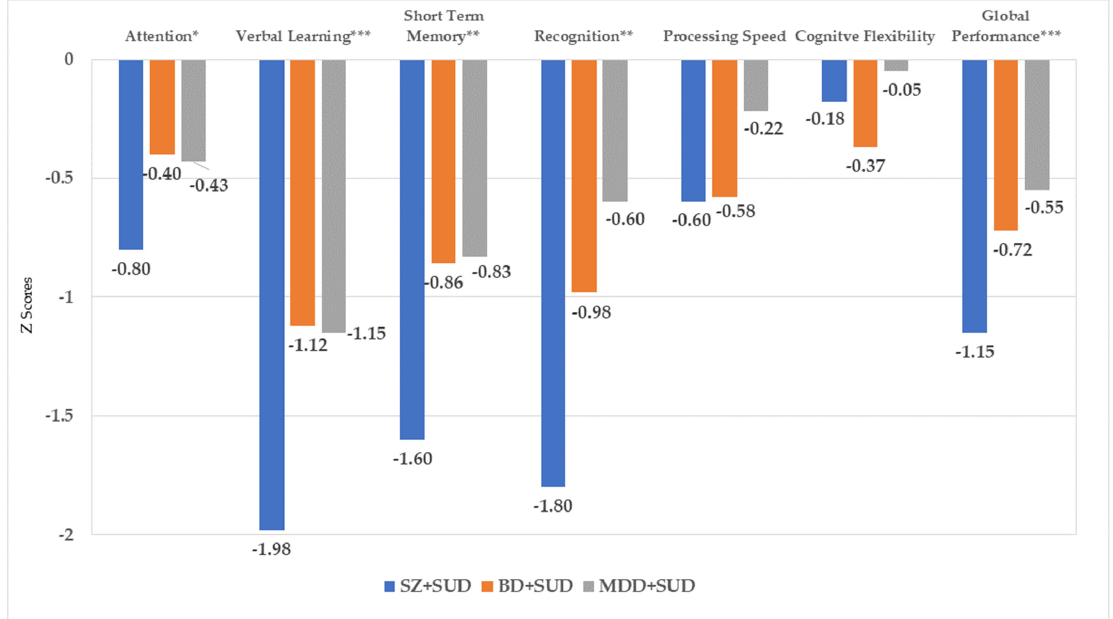
Figure 2. Z scores on the assessed cognitive domains for each of the groups. Note: Attention is composed by digits (WAIS III) and A1 (RAVLT). Verbal learning refers to total words (RAVLT). Short term memory is composed by A6 (RAVLT). Recognition refers to Recog. list A/15 (RAVLT). Processing speed is TMT-A. Cognitive flexibility was calculated form Wisconsin Sort Card Test and TMT-B. SZ + SUD: schizophrenia with comorbid substance use disorder; BD + SUD: bipolar disorder with comorbid substance use disorder; MDD + SUD: Major depressive disorder and comorbid substance use disorder. * p < 0.05; ** p < 0.01; *** p ≤ 0.001.